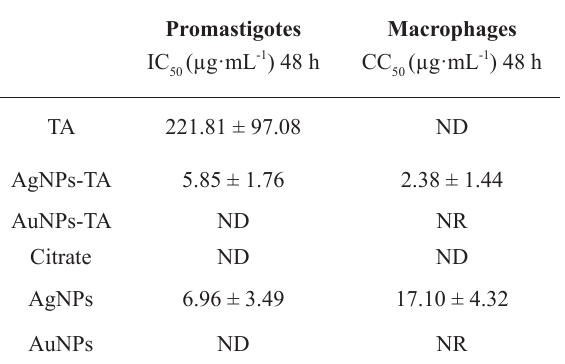
Antileishmanial and cytotoxic effects of nanoparticles and their